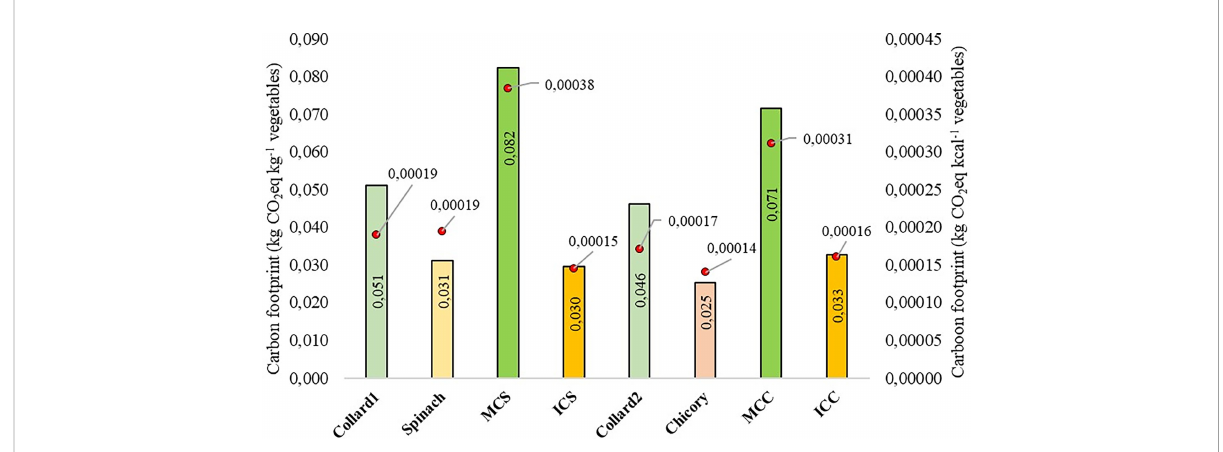
FIGURE 4 Carbon footprint (Colored bars = kg CO 2 eq kg -1 vegetable year -1 ; Red points = kg CO 2 eq kcal -1 vegetables year -1 ) for each vegetable species produced and for each system in the evaluated production scenarios: ICS – intercropping of collard greens and New Zealand spinach; MCS – monocultures of collard greens and New Zealand spinach; ICC – intercropping of collard greens and chicory; MCC – monocultures of collard greens and